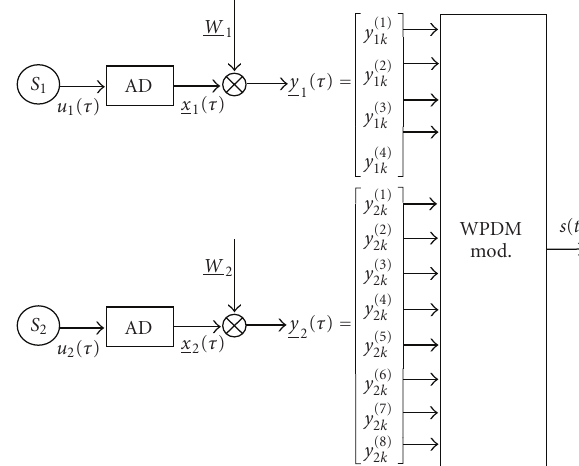
Figure 7: UPA-WPDM system for broadcasting two heterogeneous